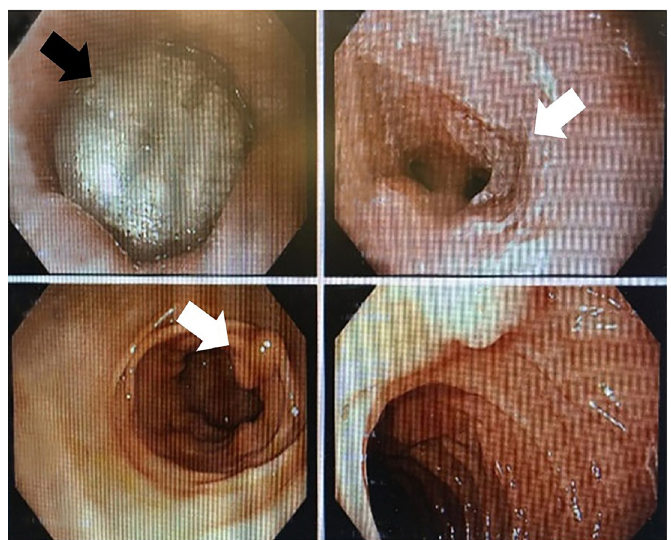
Image 3. Image of this patient’s esophagogastroduodenoscopy with the foreign body in sight at the gastroesophageal junction displaying the esophageal strictures (white arrows) as well as the trapped desiccant canister (black